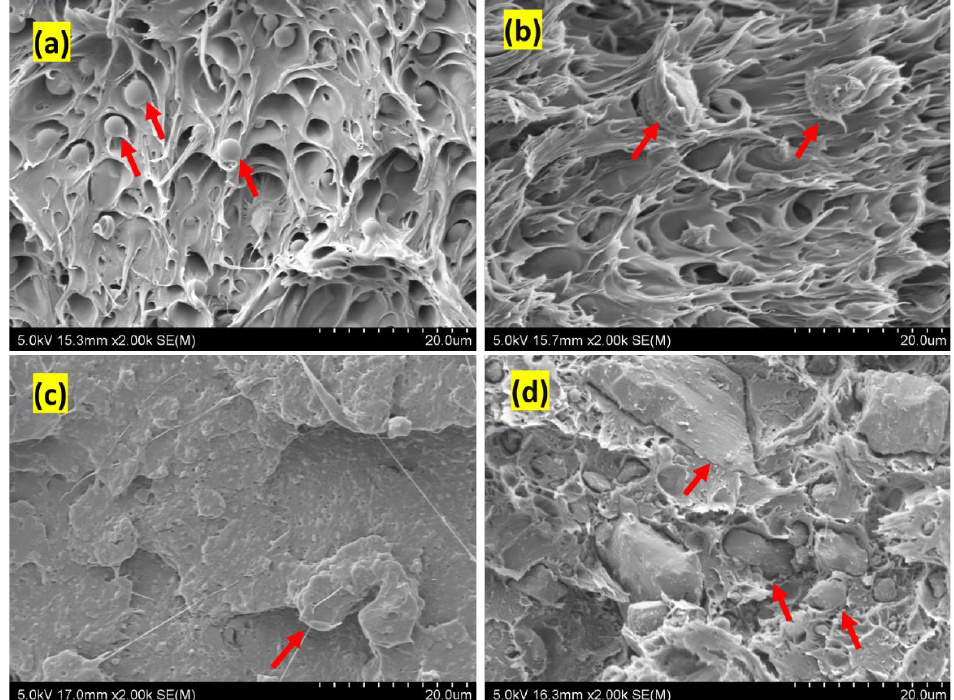
Figure 7. SEM images of fractured surfaces: ( a ) PLA/PBAT (80/20) ( b ) PLA/PBAT/BC (79/20/1) ( c ) PLA/PBAT/BC (77.5/20/2.5) and ( d ) PLA/PBAT/BC (70/20/10). [The red arrow in ( a ) shows the PBAT phase in the PLA matrix and ( b – d ), biochar particle].